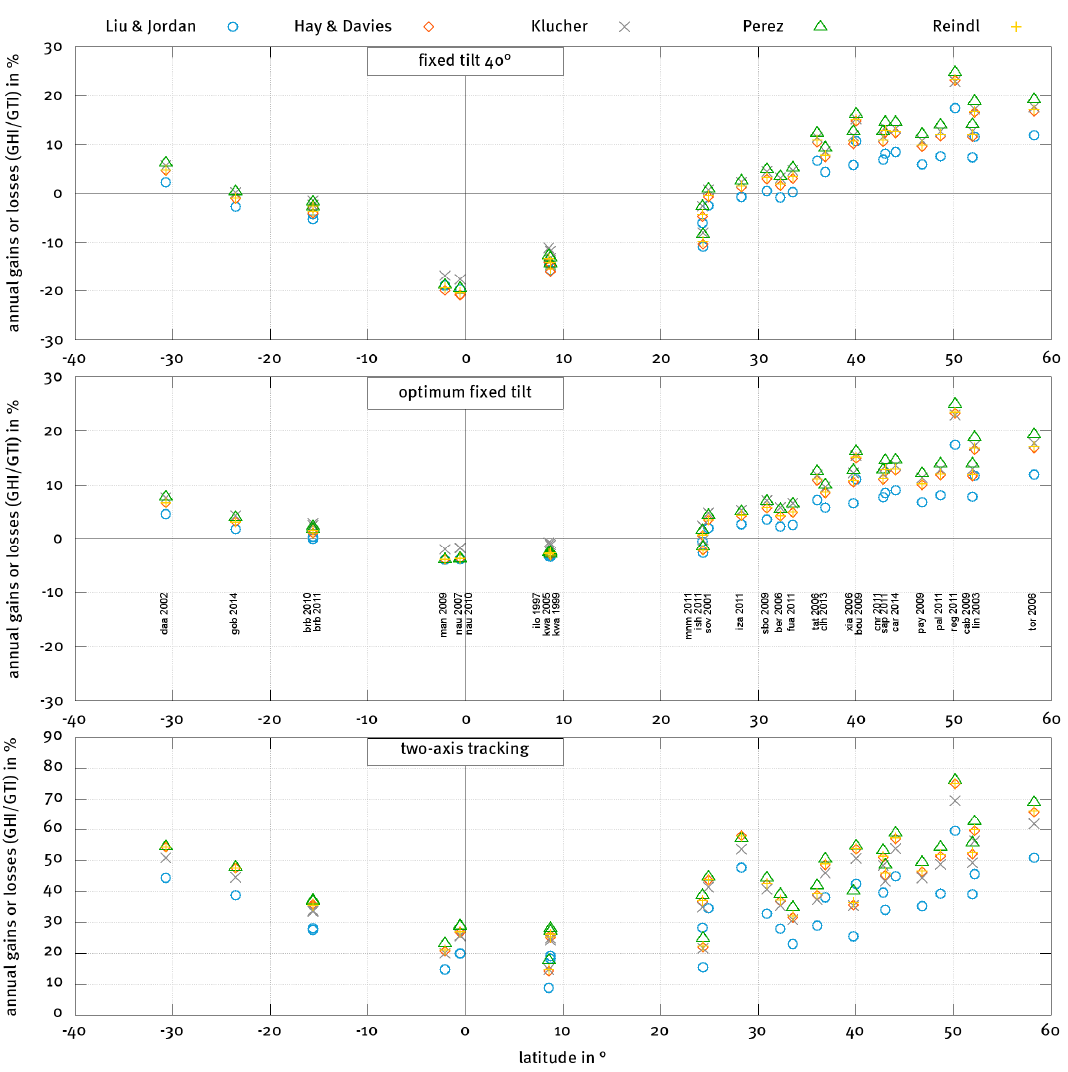
Figure 6. Annual irradiation gains and losses for the analyzed locations and three different module tilt modes: Fixed tilt at 40 ◦ , optimum fixed tilt (refer to Table 1 for location tilt angles) and two-axis tracking. A significant spread of the irradiation gains can be observed in all cases. The spread grows with increasing distance from the equator. For two-axis tracking systems, the spread is generally very high and reaches maximum differences between the lowest and highest modeled value per location of around 20% in Toravere, Estonia.